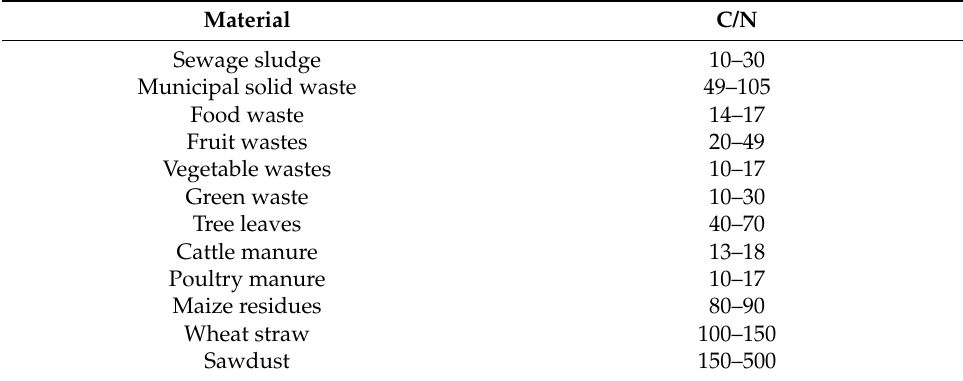
Table 2. Carbon/nitrogen ratios of various organic residues